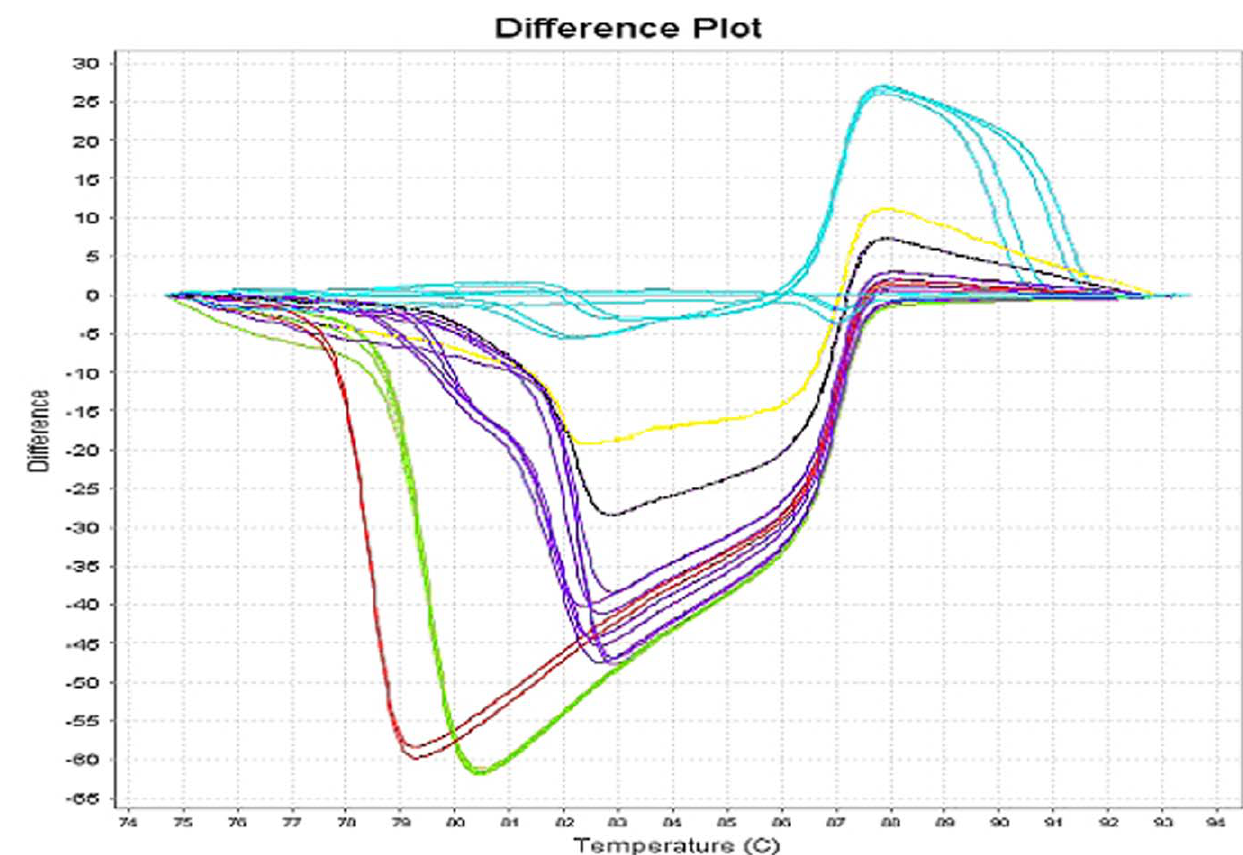
Figure 1. PCR-HRM profiles obtained with yeasts and filamentous Fungi using the primers CandUn + FungUn. In red: Candida tropicalis ; green: C. parapsilopsis ; violet: C. albicans ; black: C. glabrata ; yellow: C. krusei ; blue: Filamentous Fungi ( Aspergillus fumigatus and Fusarium solani .).